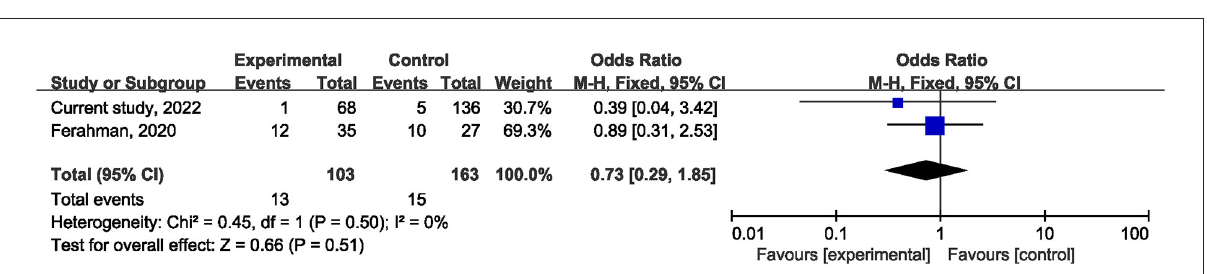
FIGURE5 The impact of the COVID-19 pandemic on the intensive care unit demand rates.